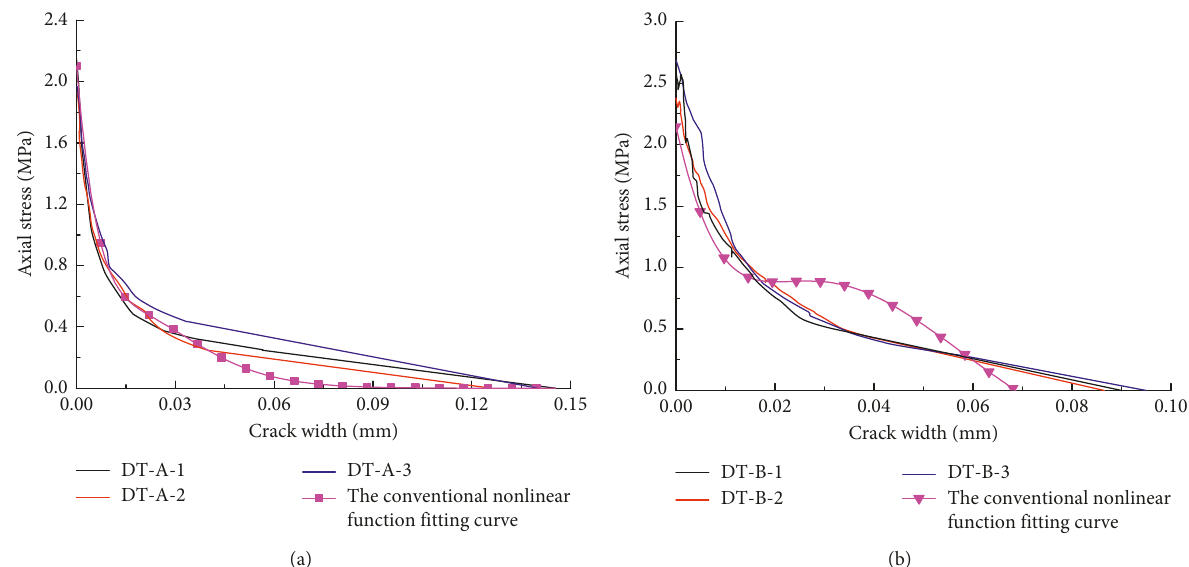
Figure 7: The result comparison of experimental and fitting curve of conventional nonlinear function. (a) 10 − 6 s − 1 ; (b) 10 − 5 s − 1